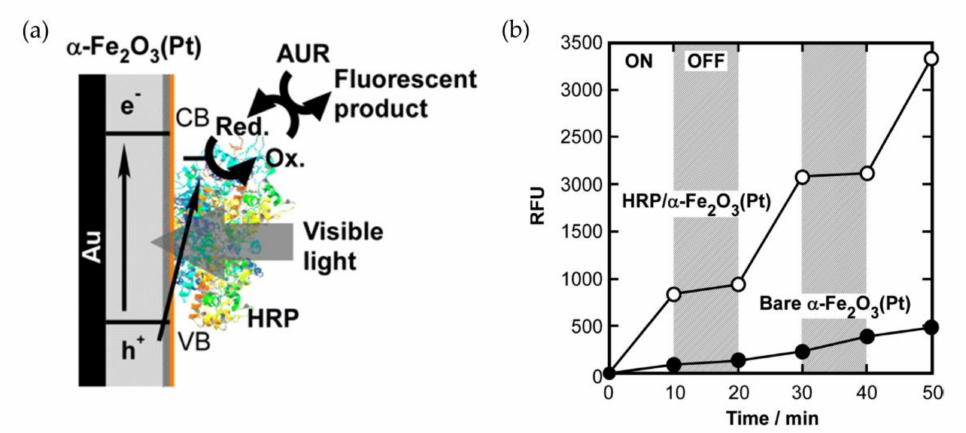
Figure 5. Light-driven conversion of Amplex Ultrared (AUR) by HRP on Pt-doped hematite thin films. ( a ) Schematic illustration of photoinduced enzymatic reaction by HRP adsorbed on Pt-doped α -Fe 2 O 3 thin film. AUR is catalytically oxidized to a fluorescent product by the HRP bound to the film under visible light illumination. ( b ) Photoswitching behaviors of catalytic oxidation of 0.1 mM AUR by bare or HRP-adsorbed α -Fe 2 O 3 (Pt) under intermittent blue light irradiation (2 mW / cm 2 ). Reprinted with permission from Kamada et al., 2012 [108]. Copyright (2012) American Chemical